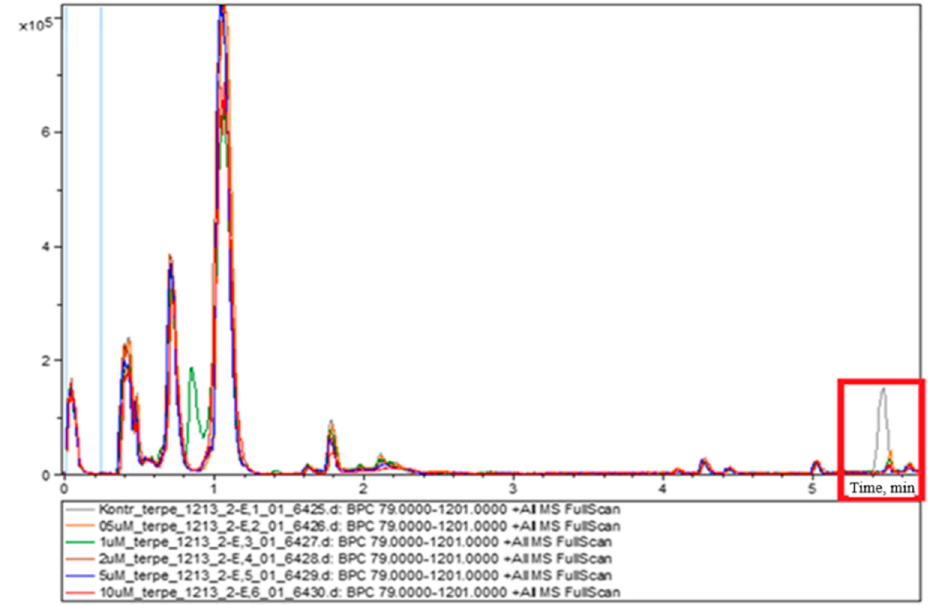
Figure 1. Chromatogram of control and treated with different rivaroxaban concentration samples measured by LC-QTOF-MS system.